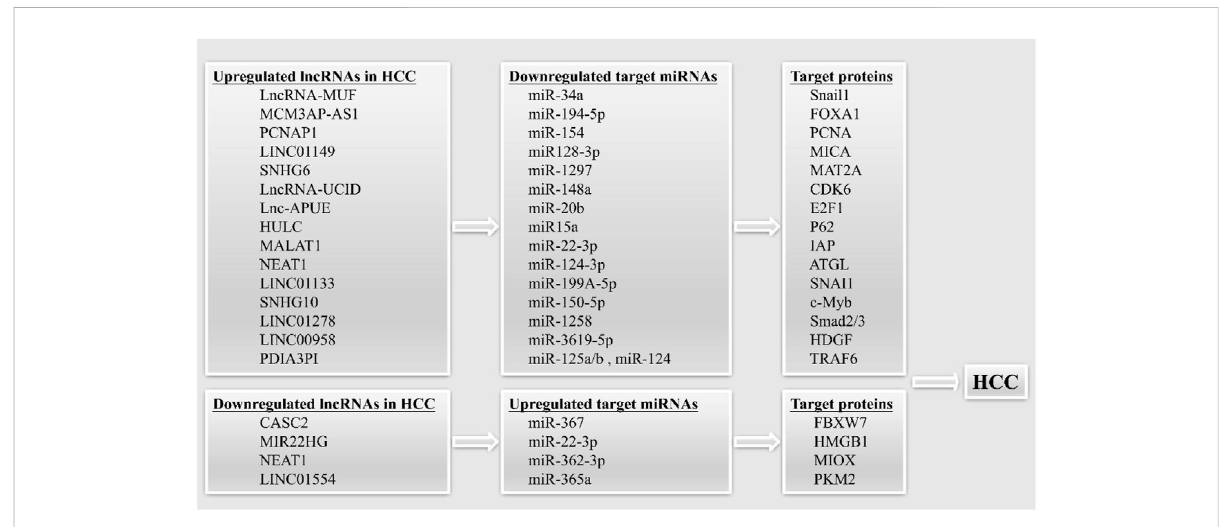
FIGURE 2 LncRNAs can act as competing endogenous RNAs (ceRNAs) in HCC. The upregulated and downregulated lncRNAs can sponging target miRNAs, leading to increased or decreased expression of target proteins, thereby promoting the occurrence of